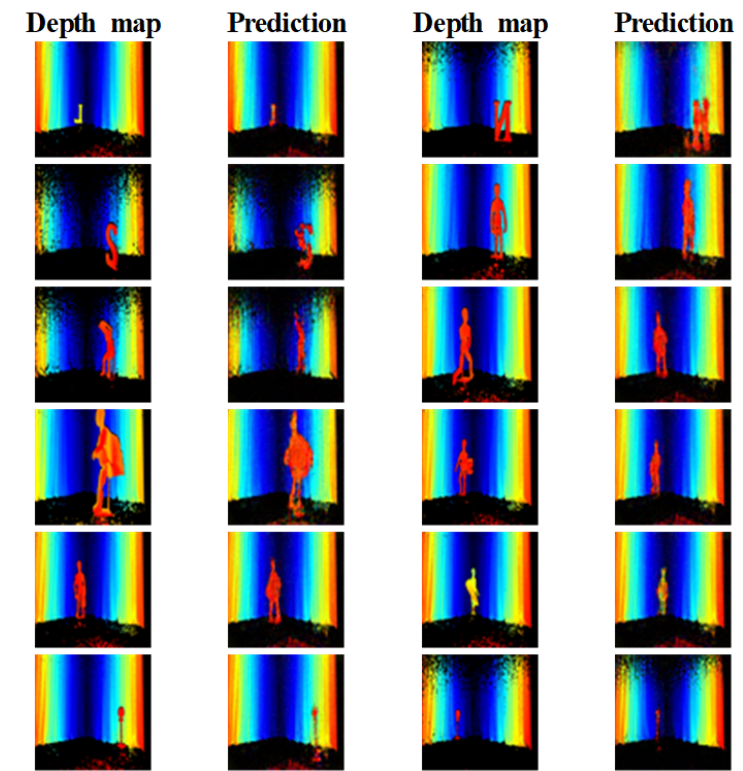
Figure 10. Qualitative result of proposed method.